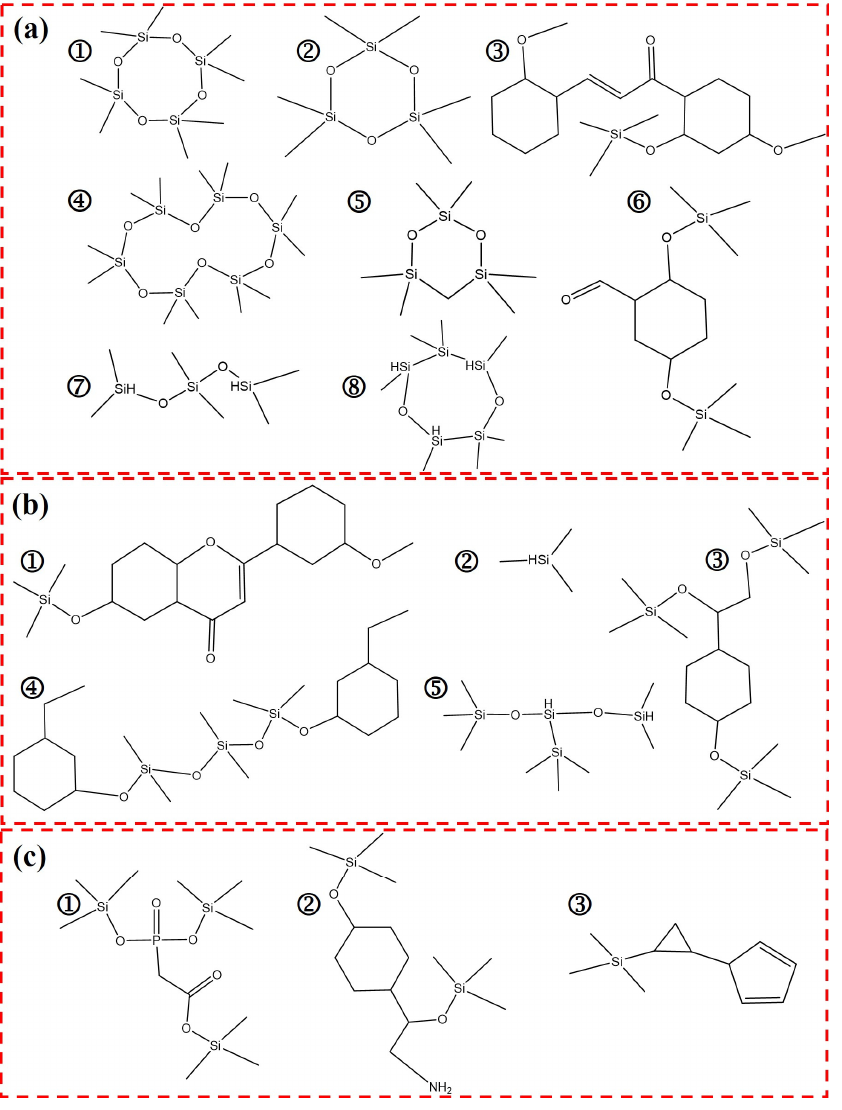
Figure 11. The molecular structures of the gaseous products released at the peaks of respective DTG maximum degradation rates for HPCTP-0 and HPCTP-25: ( a ) pyrolysis products in both HPCTP-0 and HPCTP-25; ( b ) pyrolysis products only appear in HPCTP-0; ( c ) pyrolysis products only appear in HPCTP-25.